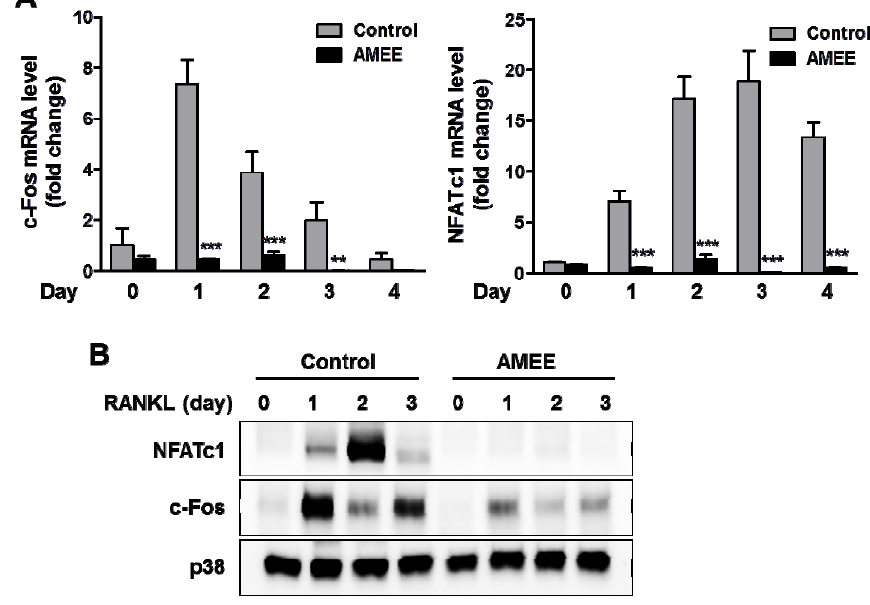
Figure 3. Effect of AMEE on RANKL-induced c-Fos and NFATc1 expression in BMMs. BMMs were cultured with vehicle or AMEE (100 μ g/mL) in the presence of M-CSF (60 ng/mL) and RANKL (100 μ g/mL) for the indicated days. ( A ) mRNA levels of c-Fos and NFATc1 were analyzed by qPCR. ** p < 0.01; *** p < 0.001 versus vehicle-treated control. ( B ) Protein expression levels of c-Fos and NFATc1 were determined by Western blot analysis. Total p38 was used as a loading